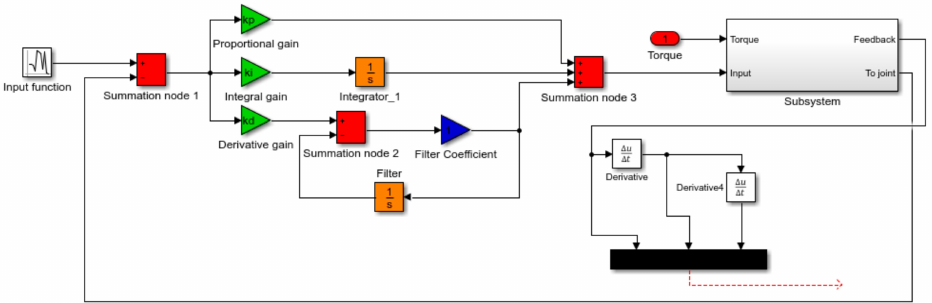
Figure 14. The PID controller model created by the block diagram method. The dashed line illustrates the connection to the joint of the surgical robot model.